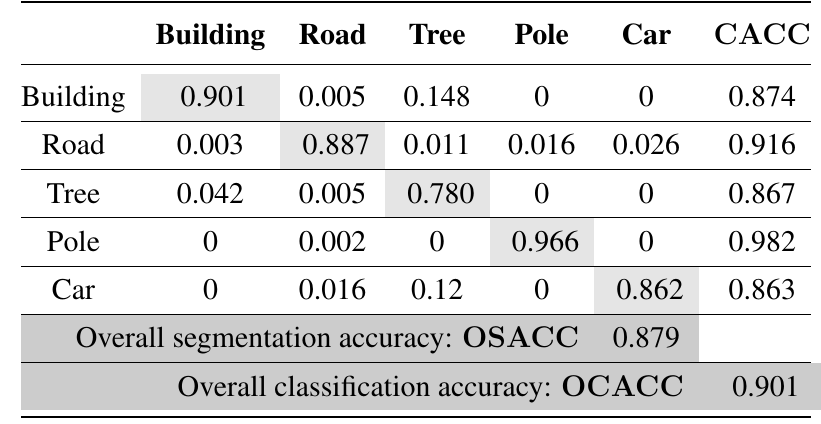
Table 4. Classification results of data set 3 with the new evaluation metrics.